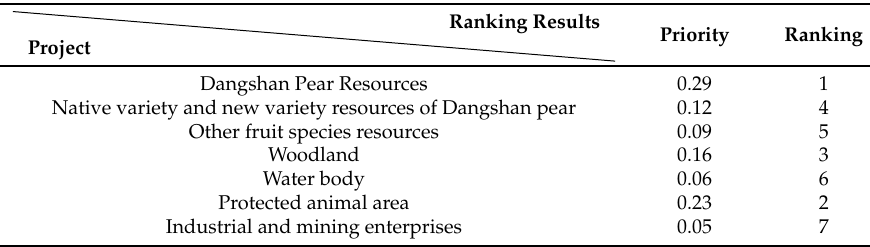
Table 10. Ranking results of tourist roles.